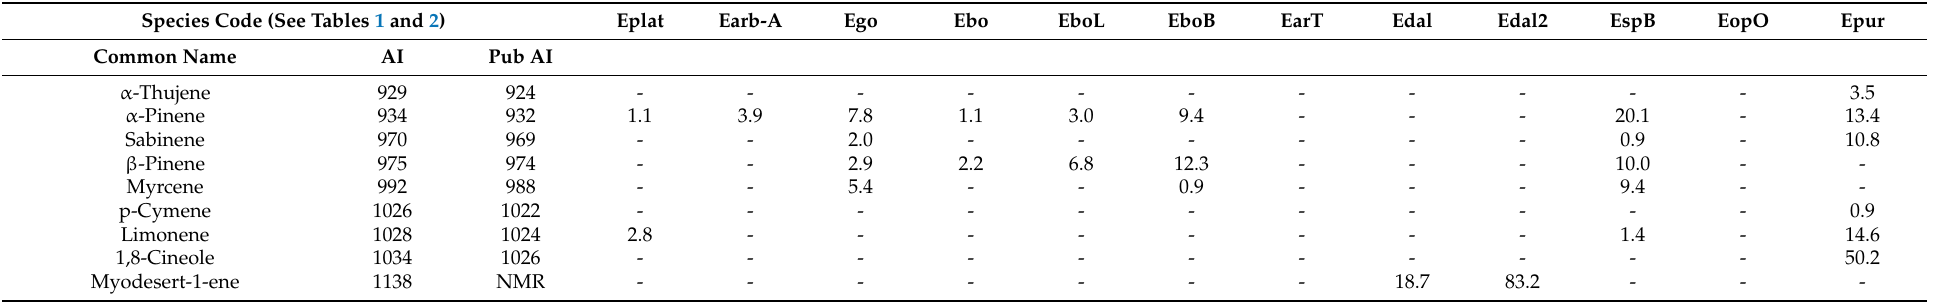
Table 10. Chemistry of solvent extract volatiles from Eremophila platycalyx (Eplat), E. arbuscular (Earb), E. goodwinnii (Ego), E. bowmannii (Ebo), E. arachnoides (Ear), E. dalyana (Edal), E. spectabilis (Esp), E. oppositifolia (Eop) and E. purpurascens (Epur). Species Code (See Tables 1 and